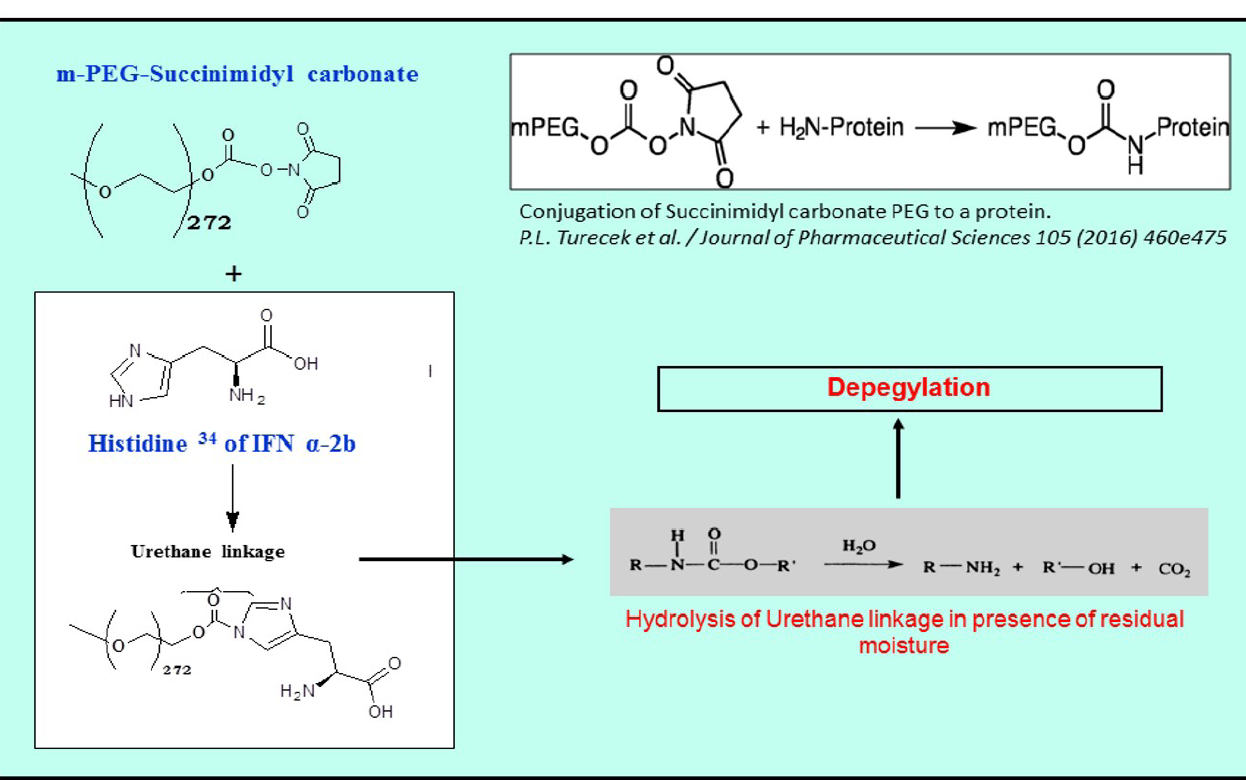
FIGURE 1 - Histidine depegylation in Peginterferon